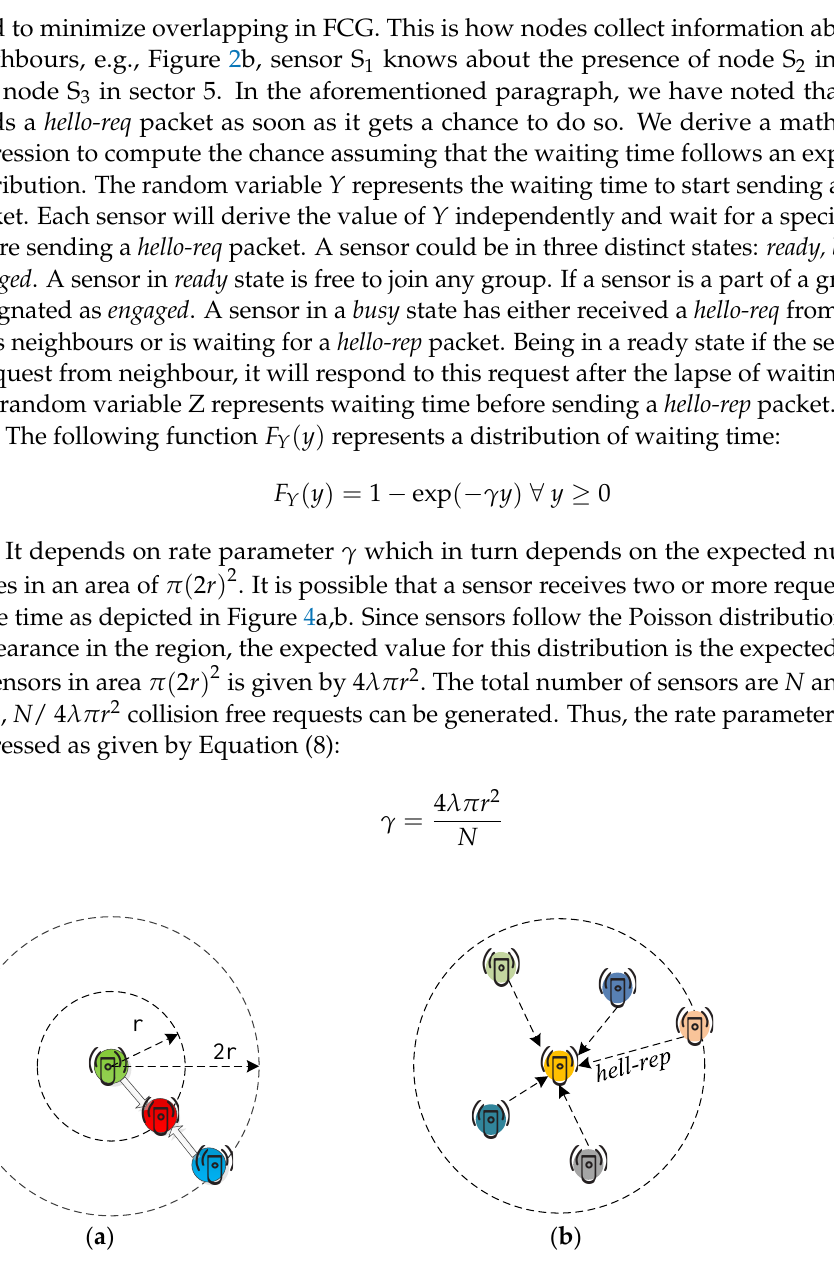
Figure 4. The interference scenario, ( a ) collision of grouping requests; ( b ) collision of grouping reply. Algorithm 1: Fast Converging Grouping (FCG)